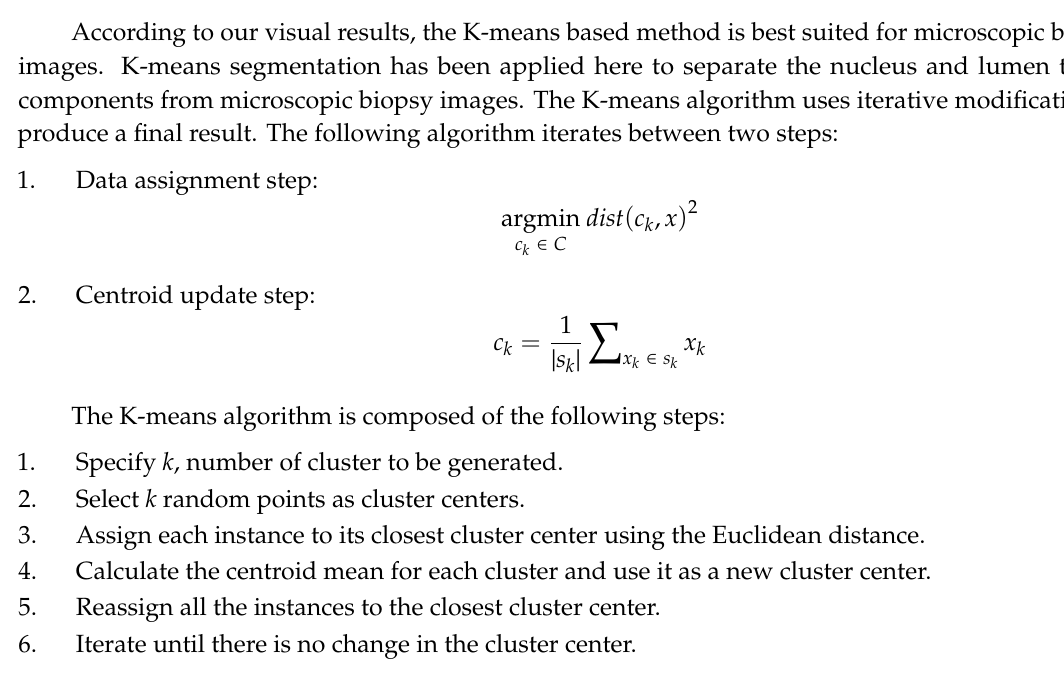
Figure 3. Image segmentation using K-means algorithm: ( a ) original tissue image; ( b ) lumen segmentation; and ( c ) nucleus segmentation.